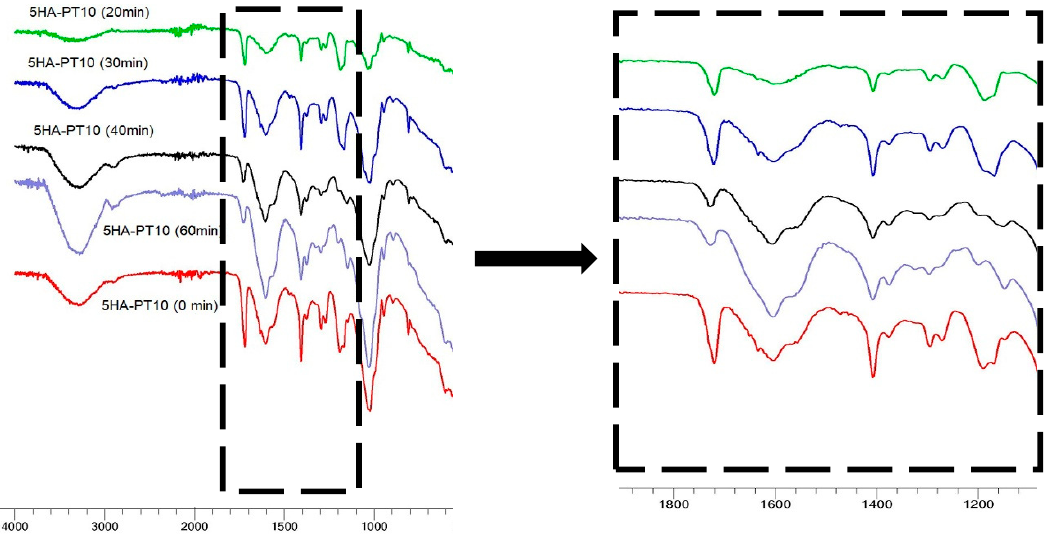
Figure 10. HA5-PT15 crosslinked by microwave irradiation (x-axis is the wavenumber / cm − 1 ).